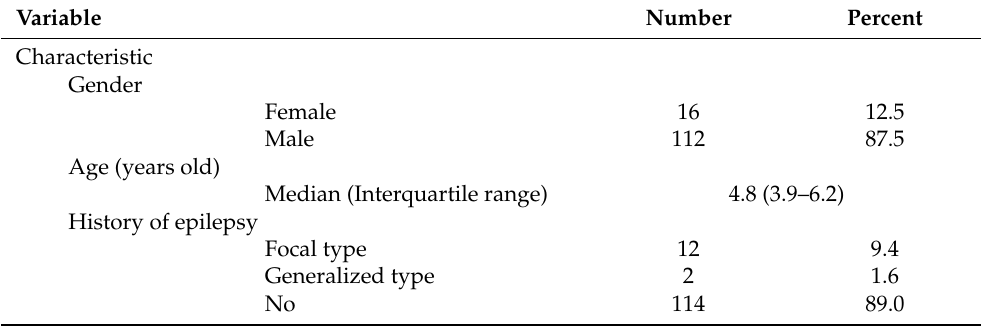
Table 1. Participant characteristics and electroencephalography (EEG), SSP (short sensory profile), and Thai-ATEC (Thai autism treatment evaluation checklist) results ( n =